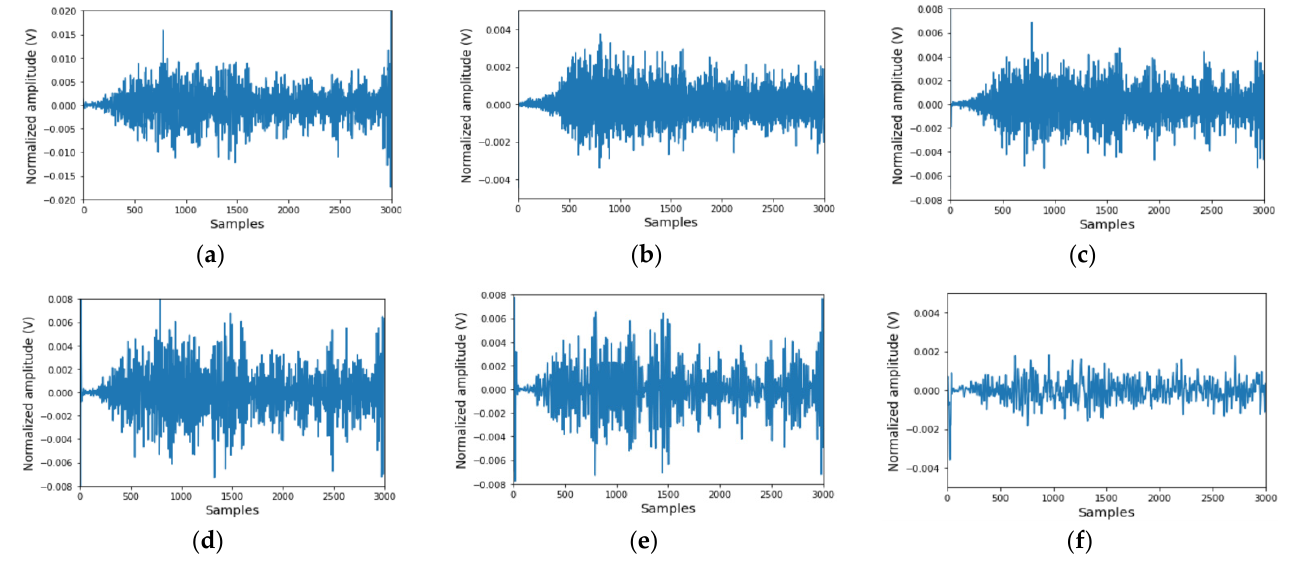
Figure 4. Maximal overlap discrete wavelet transform (MODWT) execution result. ( a ) Original signal, ( b ) level 1, ( c ) level 2, ( d ) level 3, ( e ) level 4, and ( f ) residual.